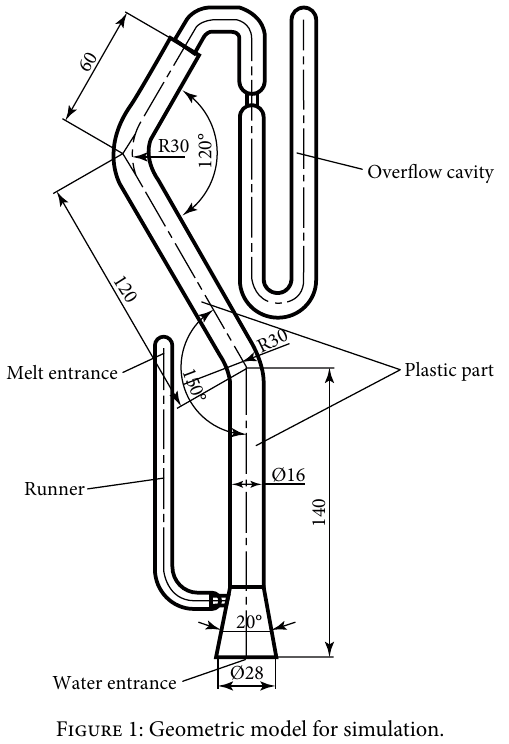
Figure 1: Geometric model for simulation.